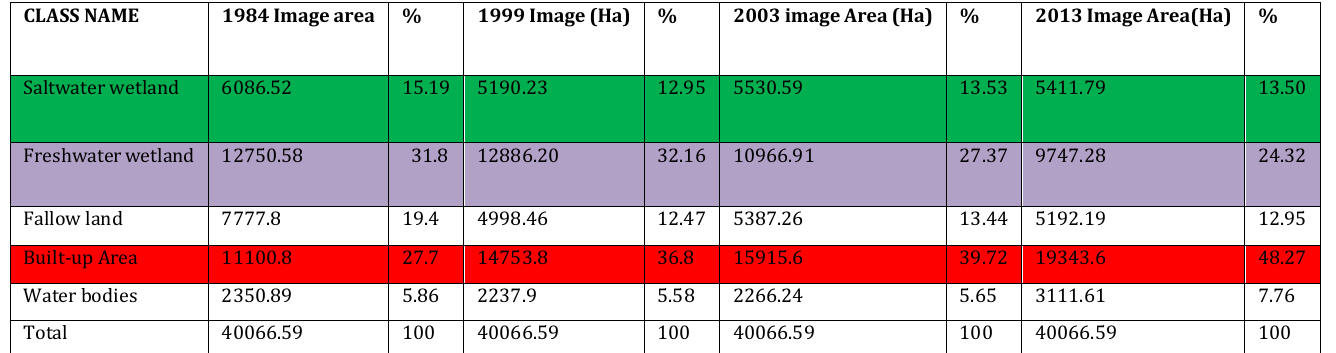
Table 3: Size and Proportion of Land Cover Classes from